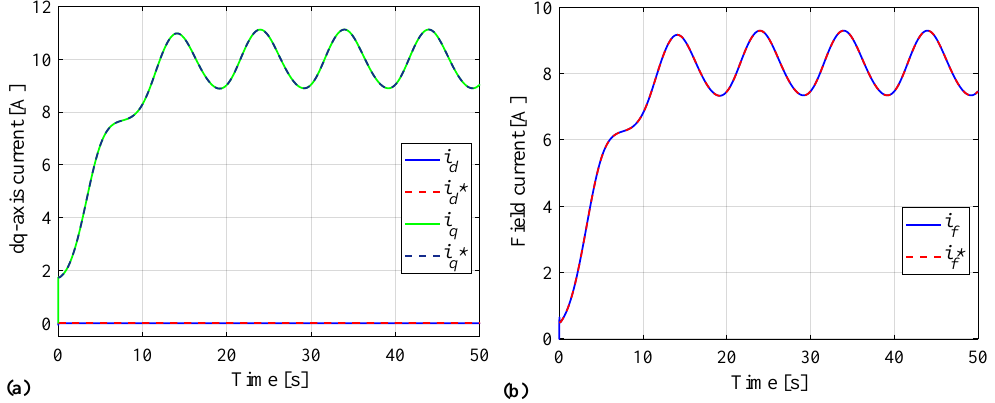
Figure 15. ( a ) dq -axis and ( b ) field currents for wind speed input of 0.1 Hz versus time.